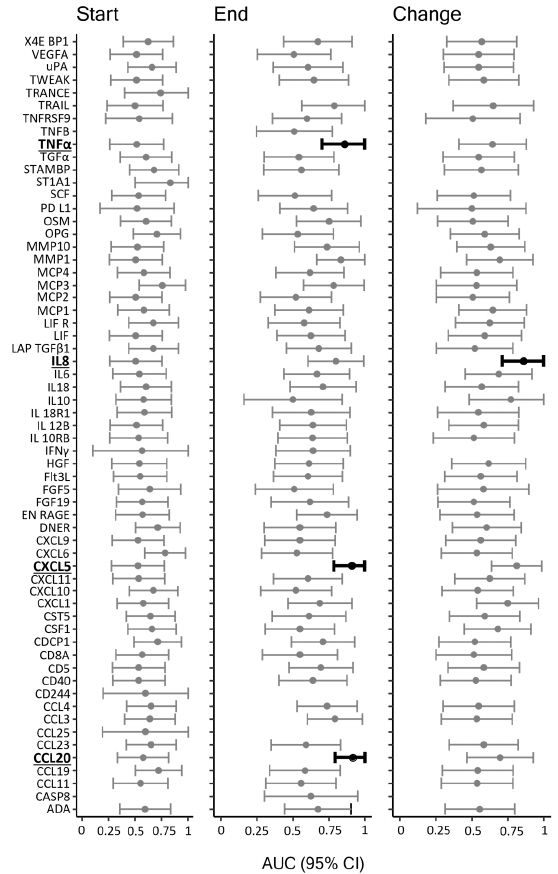
Figure 3. Inflammatory markers as predictors of functional outcome. The figure illustrates AUC and 95% CI for prediction of functional outcome for each of the detected inflammatory markers. The markers (highlighted/black bars) that reached the required level of ≥ 0.7 of the lower confidence limit were accepted as prognostic markers of functional outcome following SAH. Favorable functional outcome (mRS 0–2): n = 12; unfavorable functional outcome (mRS 3–6) n = 12; AUC: area under the curve; CI: confidence Table 2. Acceptable predictors of functional outcome measured by the Olink 96 inflammation panel. Inflammatory markers with AUC values above 0.7. AUC: area under the curve; CI: confidence in- terval; SD: standard deviation.